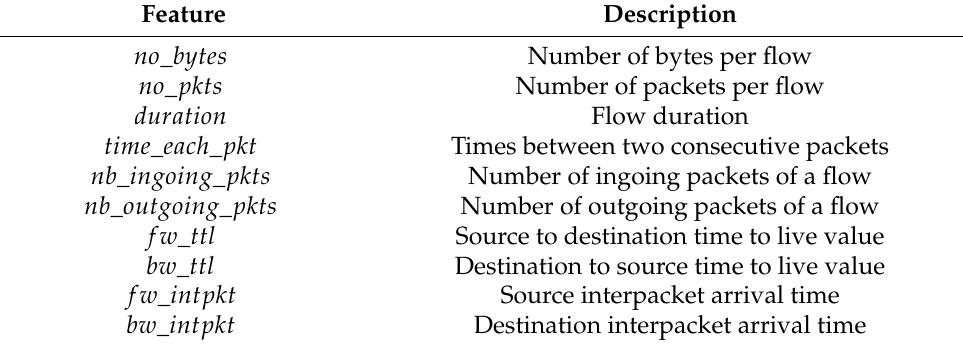
Table 4. Key Features for LSTM model.